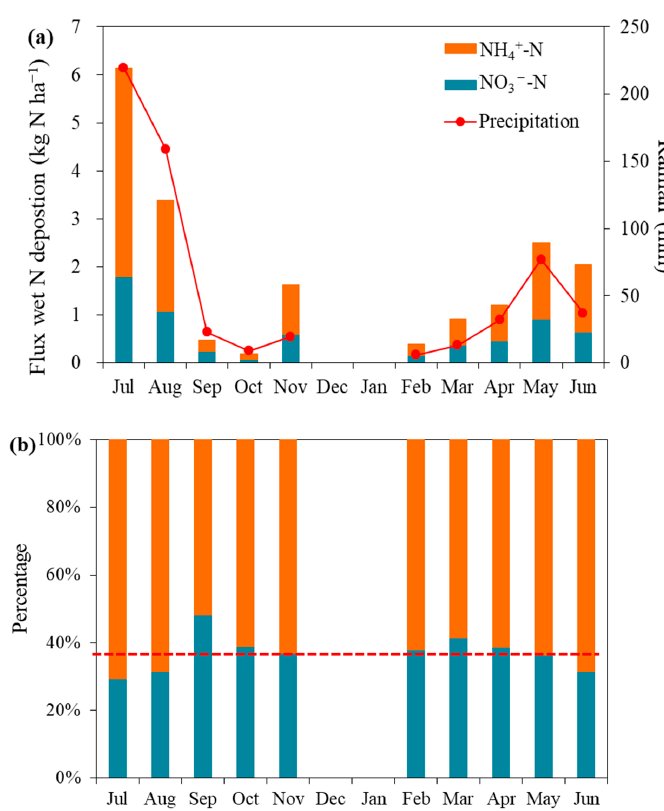
Figure 2. Monthly patterns of ( a ) wet deposition rates (kg N ha − 1 ) of NO 3 − –N, NH 4 + –N, and ( b ) their proportion of the total deposition rate of wet inorganic nitrogen (DIN) at the DHT reservoir, a rural